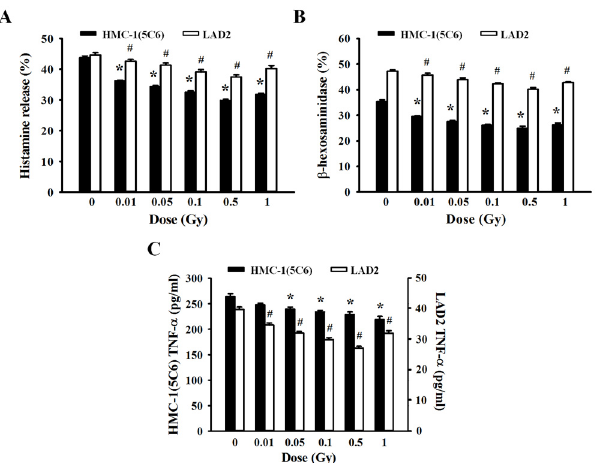
Fig 2. Inhibitory effects of radiation on mediator release and cytokine production by human mast cells. HMC-1(5C6) and LAD2 cells were incubated for 30 min in medium containing human IgE. Cells were exposed to ionizing radiation (0 – 1 Gy) before the addition of anti-IgE. The histamine concentration (A), β - hexosaminidase concentration (B), and cytokine (TNF- α ) production (C) were determined in supernatants. Data represent the mean ± SEM from five independent experiments performed in duplicate. * p < 0.05, # p < 0.05 versus the corresponding control group of HMC-1(5C6) and LAD2 cells, respectively.